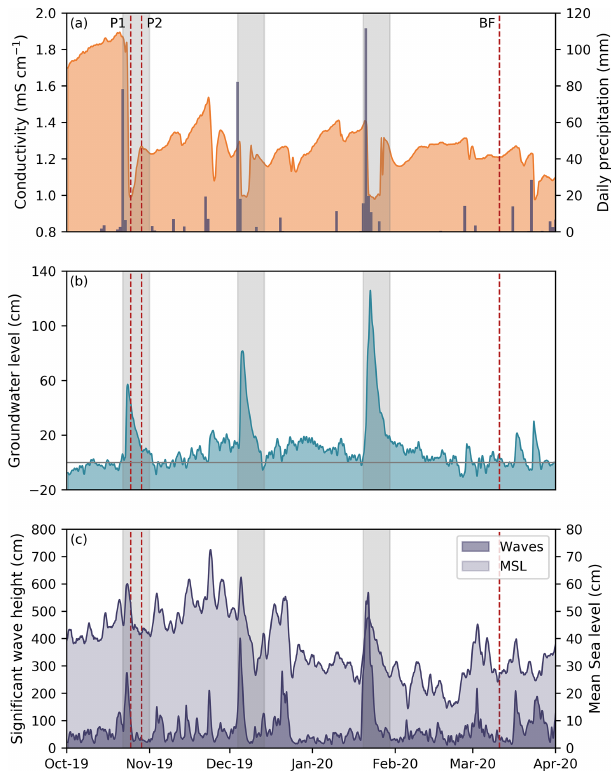
Figure 2. Temporal evolution of meteorological, oceanographical, and hydrogeological data in Maresme County: (a) specific conduc- tivity measured at the shallow piezometer N3-15 and accumulated precipitation, (b) groundwater level, and (c) significant wave height and mean sea level (MSL). Groundwater level is displayed as the variation of groundwater level relative to the values of March 2020. The data from the buoy and CTD diver was smoothed by using a low-pass filter (12h averaged). Red lines indicate the groundwater and seawater samplings performed at the study site (P1, P2, and BF) and gray bands indicate the EPEs that took place during the moni- toring period (10d after the event are included in the